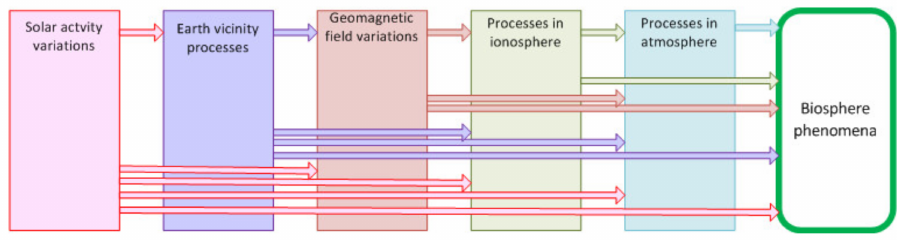
Figure 1. The illustration of the environmental impact on a living